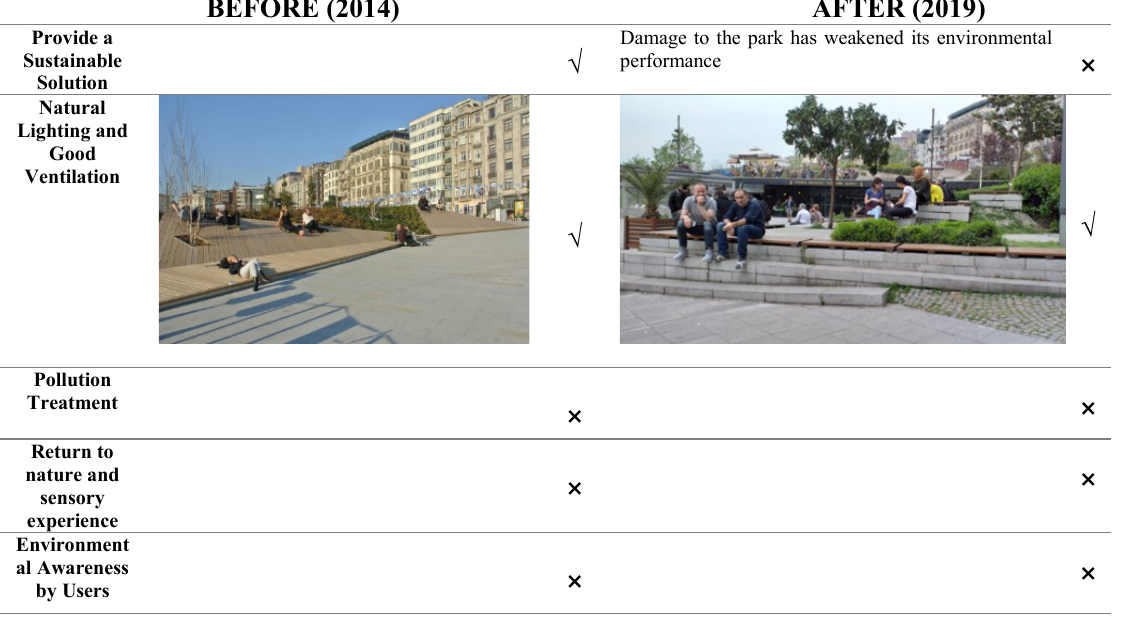
Table 8. Analysis of "Şışhane Park" according to derived environmental elements; (Improved by author); figures source (Before: URL8, after: by authors). BEFORE (2014) AFTER (2019) Damage to the park has weakened its environmental performance